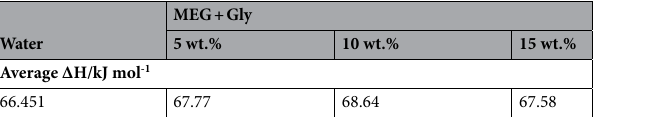
MEG + Gly Water 5 wt.% 10 wt.% 15